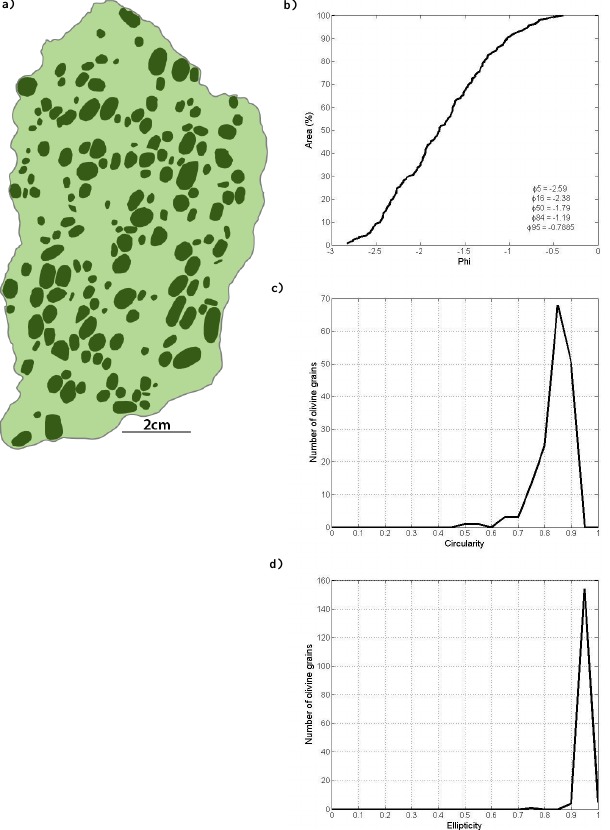
Figure 4. Grain size analysis of olivine grains in the IH53 lava. (a) False-colour digitised image of polished slab of IH53 lava; olivine are coloured dark green. Total slab area is 7138mm 2 and comprises ∼ 27% xenocrystic olivine. (b) Histogram showing the olivine percentage area as a function of grain size. The grain size is expressed as ϕ = − log 2 (d) , where d is the olivine diameter. (c) Frequency distribution curve of circularity ( C ) of olivine grains de- fined as C = (Perimeter) 2 / (4 π * Area). C = 1 for a perfect circle, and values 0 < C < 1 provide a relative quantification of roundness. (d) A distribution curve, showing the number of olivine grains hav- ing a specific